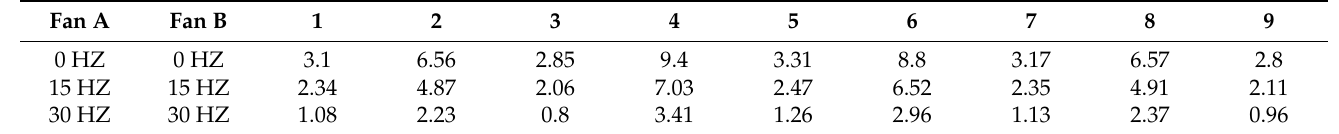
Table 4. Total mass of ammonia in calculation area corresponding to working frequency of FAN A and FAN B (unit: mg).